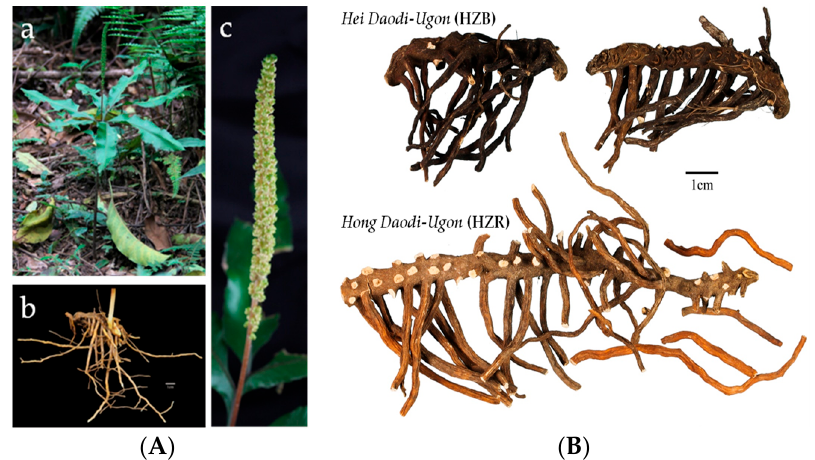
Figure 1. ( A ) The original plant of HZ: ( a ) fronds tripartite, each division with two to three (or more) lanceolate lobes; ( b ) root and rhizome creeping, fleshy and fronds usually single at rhizome apex; ( c ) spikelike sporophore arising at top of common stipe; ( B ) The herbal HZ samples of Hei Daodi-Ugon : HZB and Hong Daodi-Ugon : HZR.